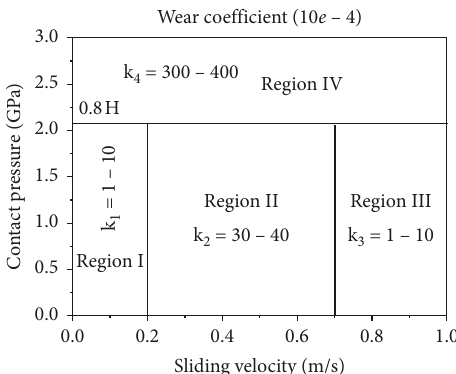
Figure 10: Wear coefficient of Archard’s model.